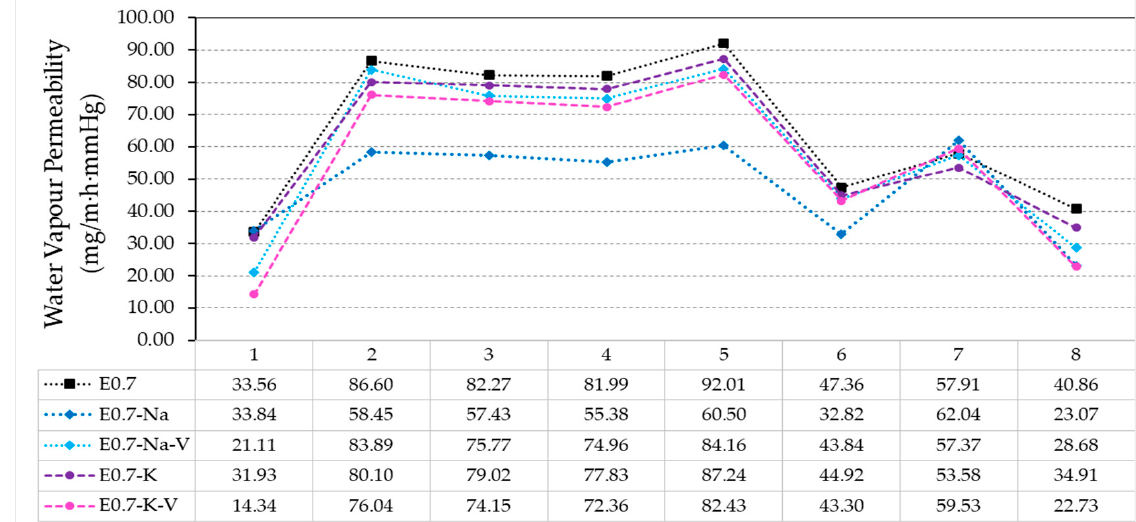
Figure 4. Relative water vapor permeability test results.